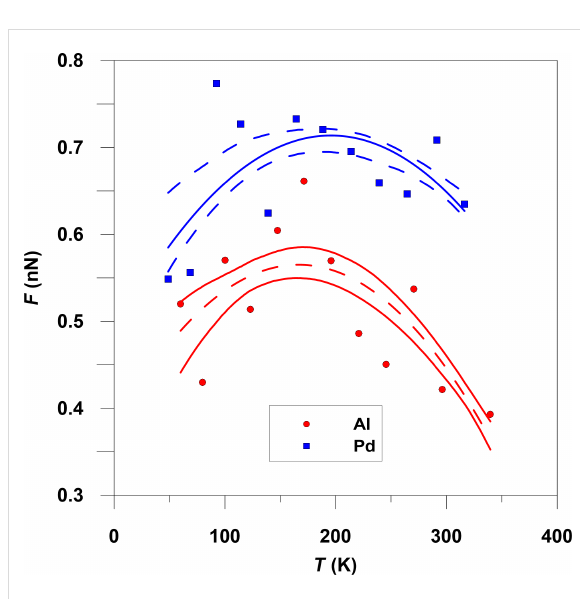
Figure 8: Friction force versus temperature with confidence intervals of the second-degree polynomial approximation. potential that exhibits a smaller energy corrugation along the sliding path and lower friction. Thus, we expect the friction force to exhibit a maximum at a characteristic temperature (that increases with increasing sliding